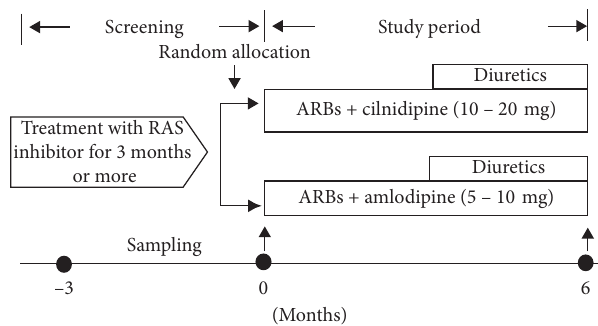
Figure 1: Study design. Patients received either 10mg per day of cilnidipine, which was increased to a daily dose of 20mg, or 5mg per day of amlodipine, which was increased to a daily dose of 10mg. Doses of RAS inhibitors were not altered when the combination with amlodipine failed to reduce BP to the target level within 3 months. Instead, additional antihypertensive medications, such as diuretics, were administered to achieve the target